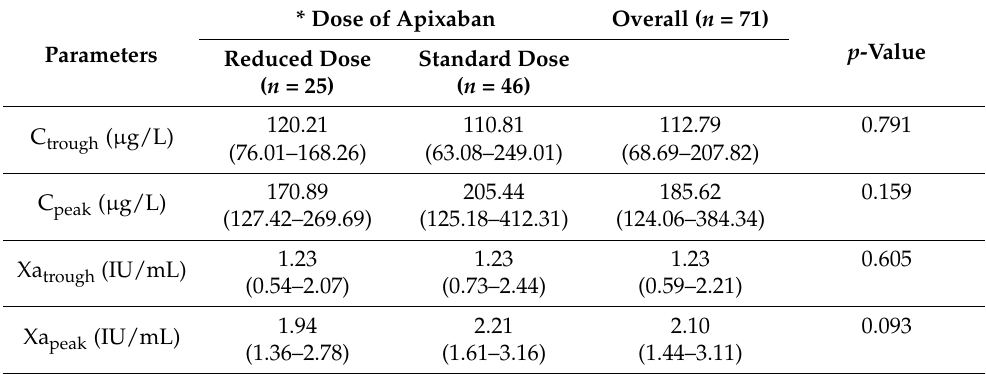
Table 2. The trough and peak values of the apixaban plasma levels and anti-FXa activities at steady